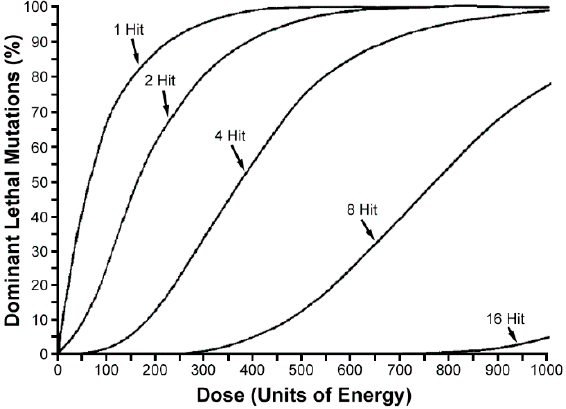
Figure 5. Computer-simulated curves for the induction of dominant lethal mutations in insect sperm. Shape of the curve changes as the number of hits required for a dominant lethal event increases. (Reproduced from [55] with permission of Elsevier).